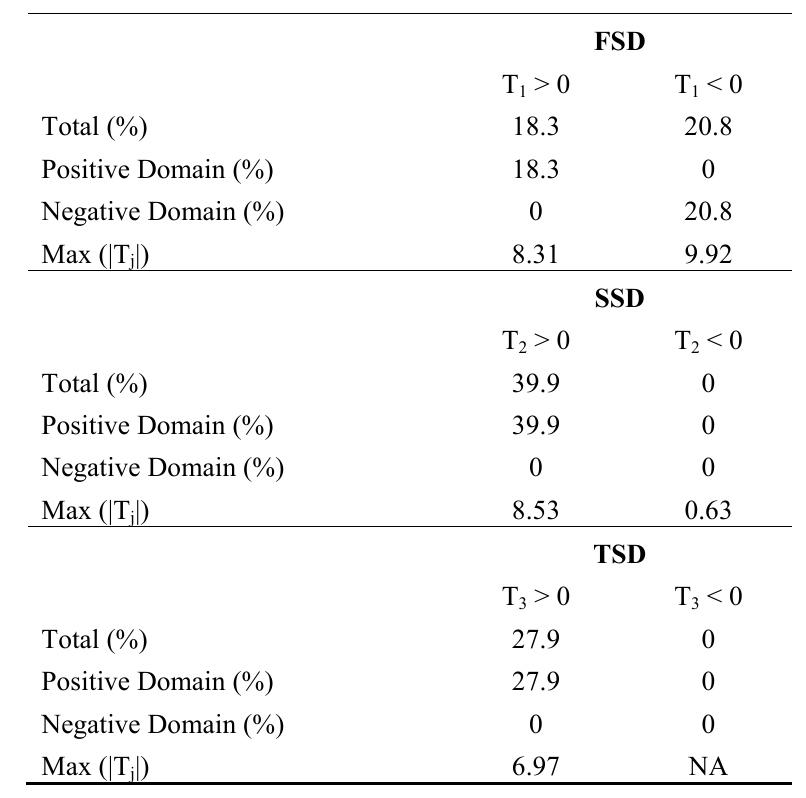
Table 6. The results of the stochastic dominance (SD) statistics for the first domestic diversified portfolio (DOD1) and the second international diversified portfolios